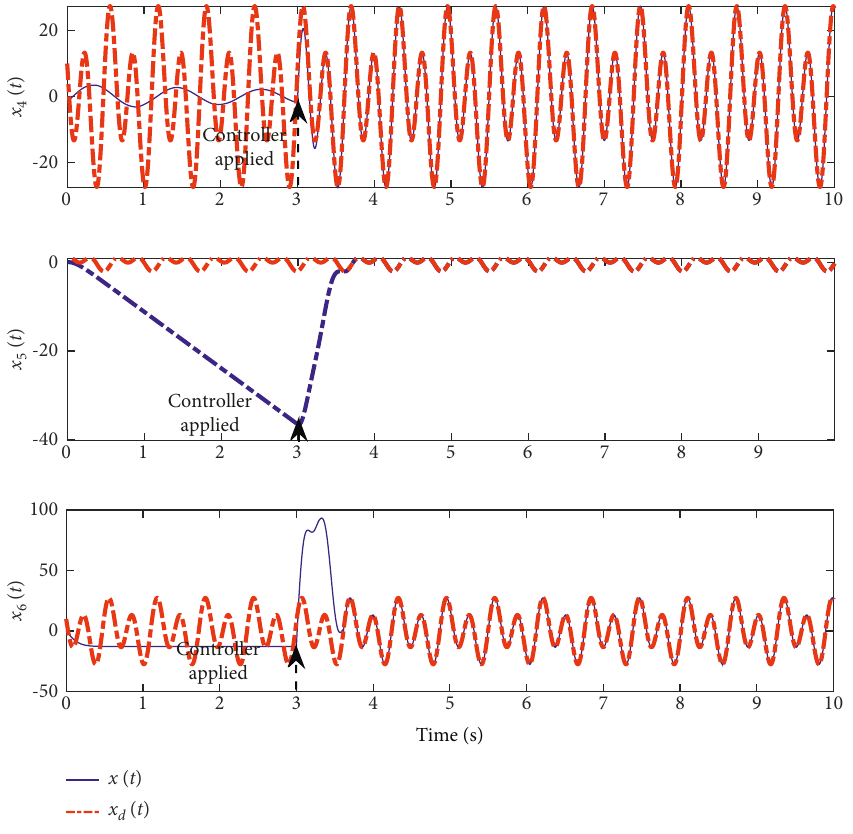
Figure 3: Time responses of x